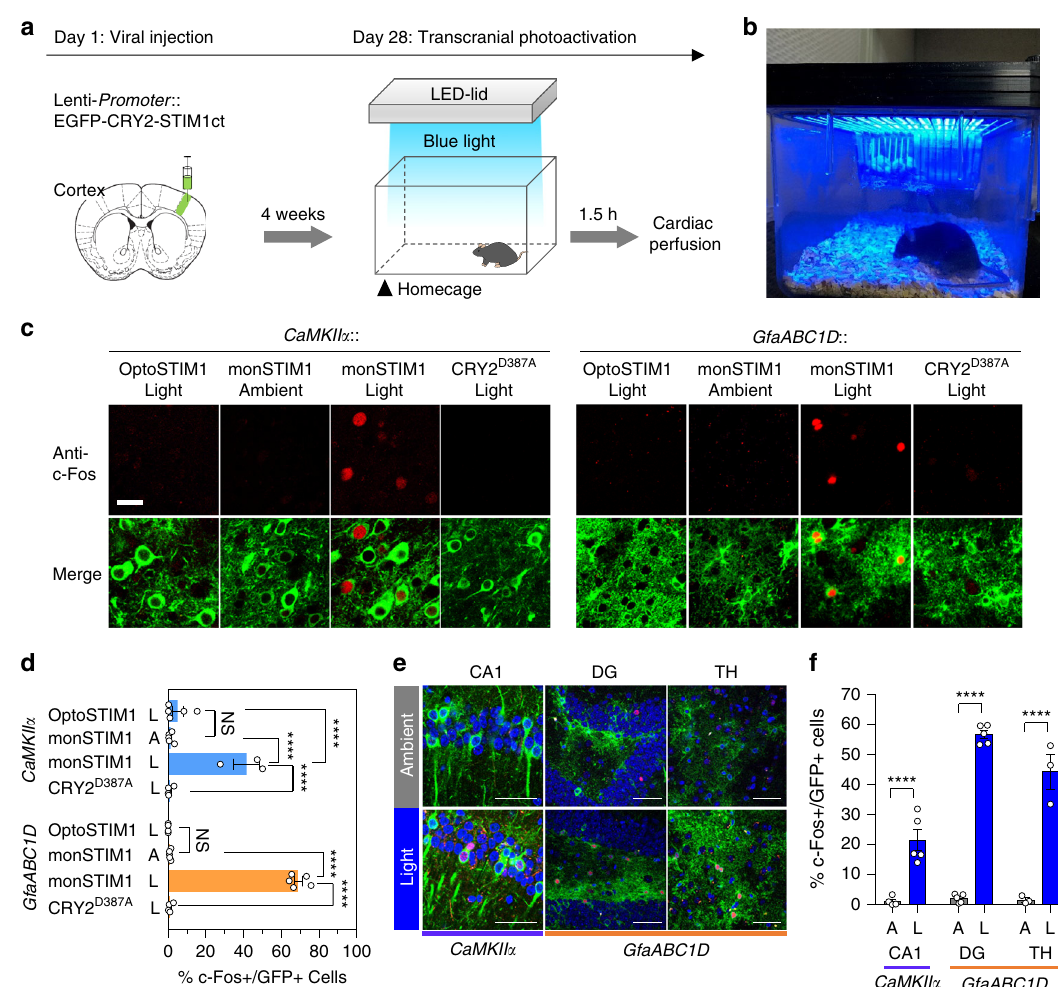
Fig. 2 Optogenetic Ca 2 + modulation in the brain through non-invasive light delivery. a Schematic representation of the procedure for variable OptoSTIM1 expression and activation by non-invasive light stimulation. Lentivirus packaged with different OptoSTIM1 variants expressed under the control of either a CaMKII α promoter (excitatory neurons) or GfaABC1D promoter (astrocytes) targeted to the S1 cortical region. Four weeks post injection, mice were illuminated with LED light in their homecage and subsequently killed. b Customized transcranial light illumination system. A solid-state LED is attached to the cage lid, and its light intensity is controlled by a panel. c Representative images showing c-Fos – positive cells expressing each OptoSTIM1 variants. Scale bar, 20 μ m. d Summary plot showing quanti fi ed population of c-Fos – positive ( + ) cells expressing OptoSTIM1 variants (**** P < 0.0001; Sidak ’ s tests). e Representative images of c-Fos-stained cells with or without monSTIM1 activation in designated brain regions. Blue, DAPI; Red, c-Fos; Green, monSTIM1. Scale bar, 50 μ m. f Graph showing the percentage of c-Fos – positive cells expressing monSTIM1 in e . (**** P < 0.0001; Sidak ’ s tests). Images and quanti fi ed data are representative of multiple experiments ( n > 3). Data represent means ±